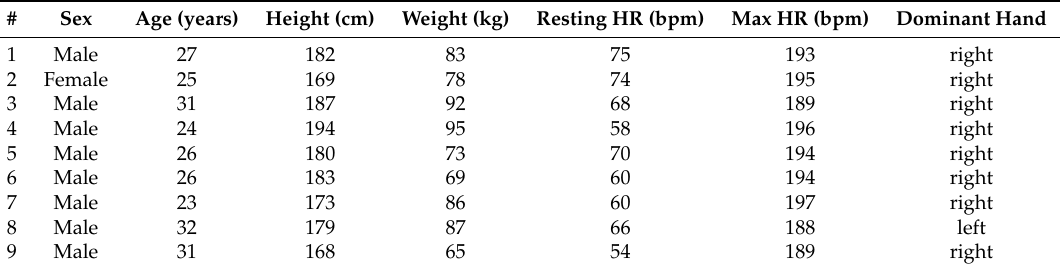
Table 1. Physiological information about the subjects participating in the data acquisition protocol. HR, heart